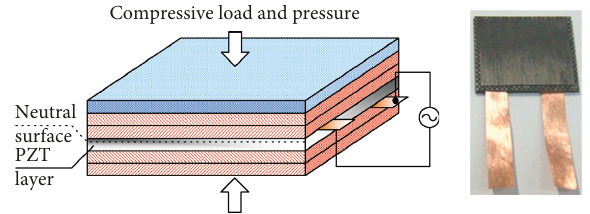
Figure 1: Concept of multilayered d Figure 3: Composition of the proposed pot bearing-type BWIM: 33 -mode PCGE and manu- factured (1) pot plate, (2) elastomeric disc, (3) brass sealing ring, (4) piston with PTFE, (5) upper sliding plate, and PCGE installed in the bearing [14–16].